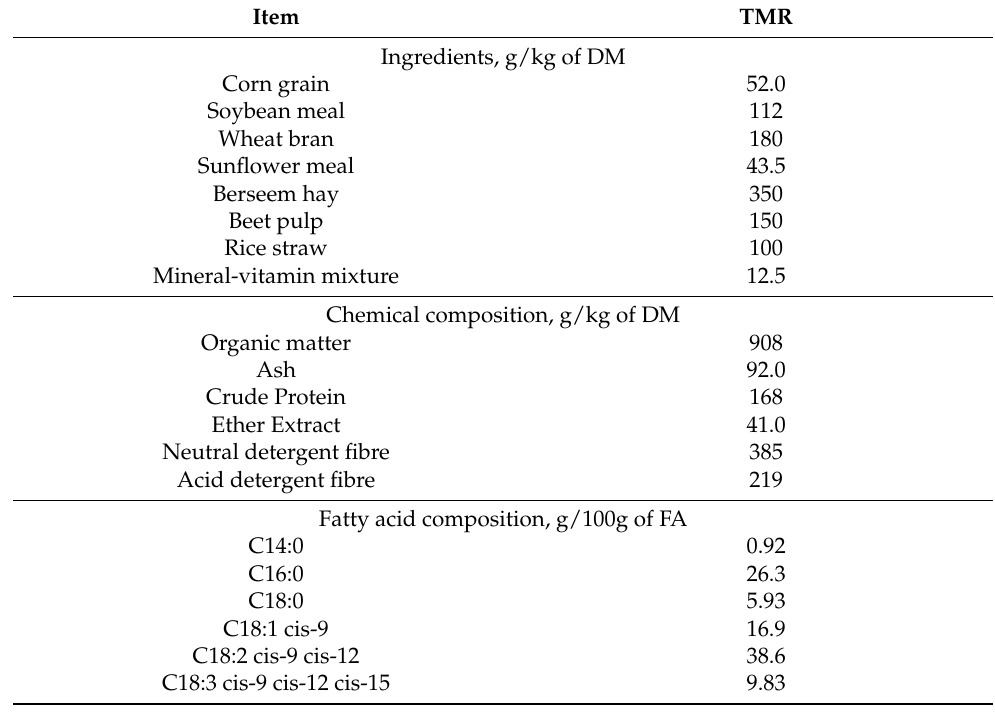
Table 1. Ingredients and chemical composition of the total mixed ration